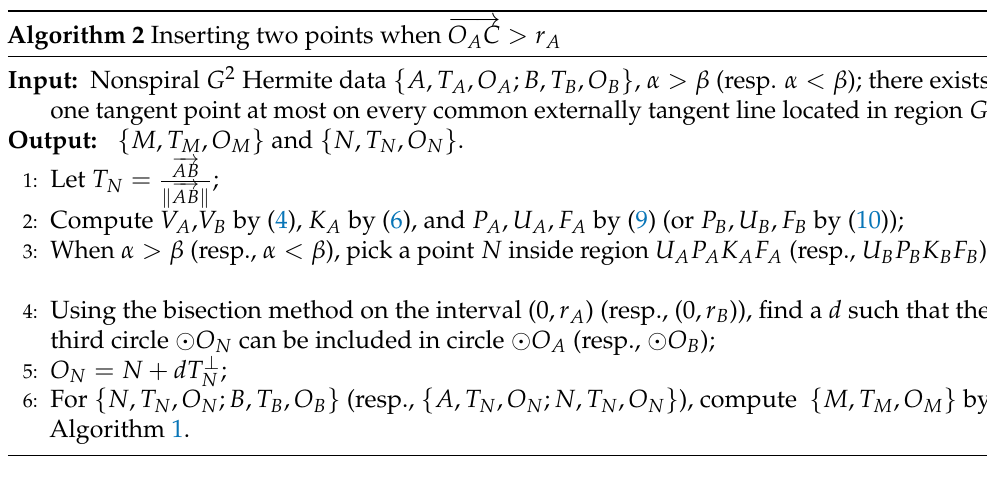
Algorithm 2 Inserting two points when